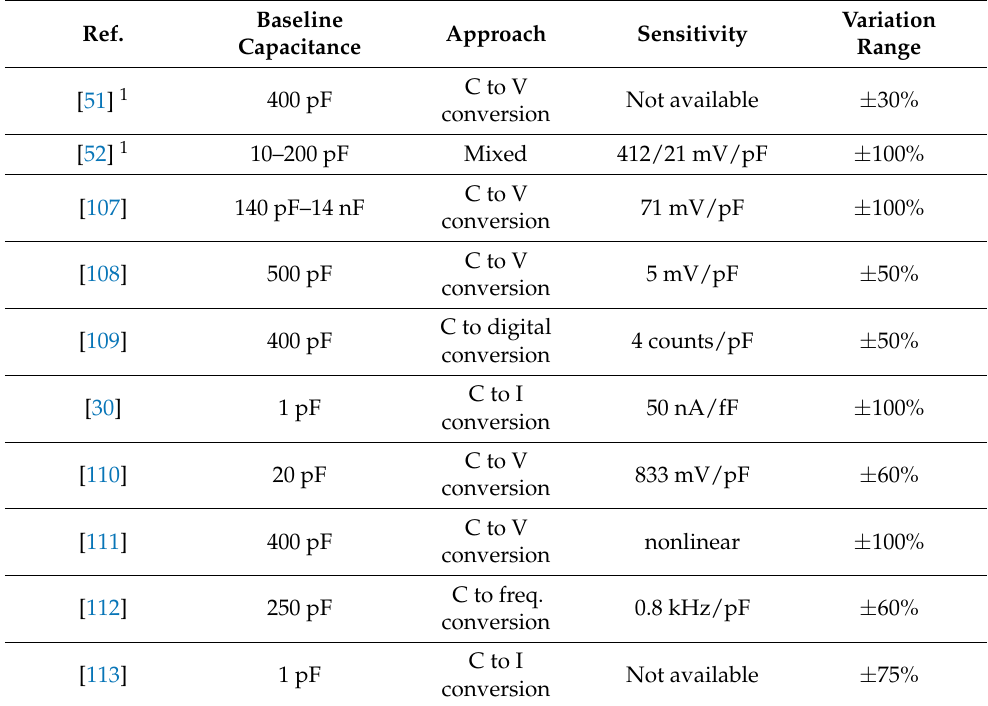
Table 2. Comparison between current-mode read-out circuits for differential capacitive sensors and conventional ones.